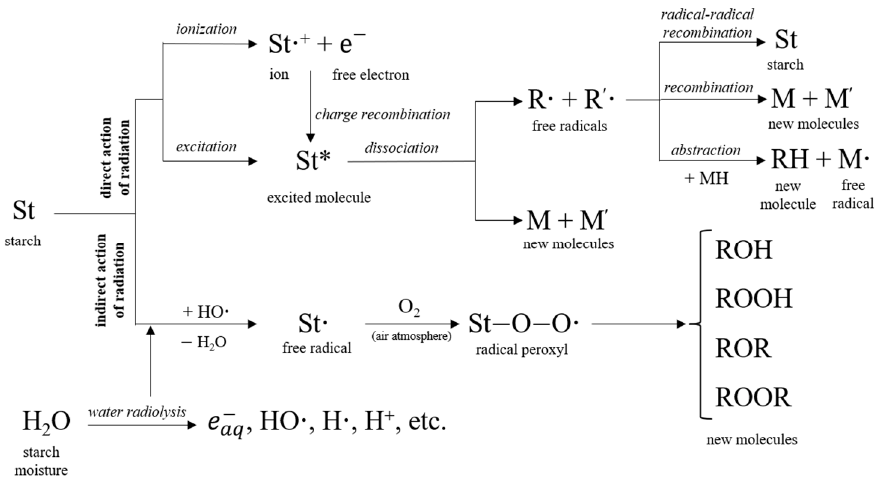
Figure 5. Oxidative degradation mechanism for radiation-processed